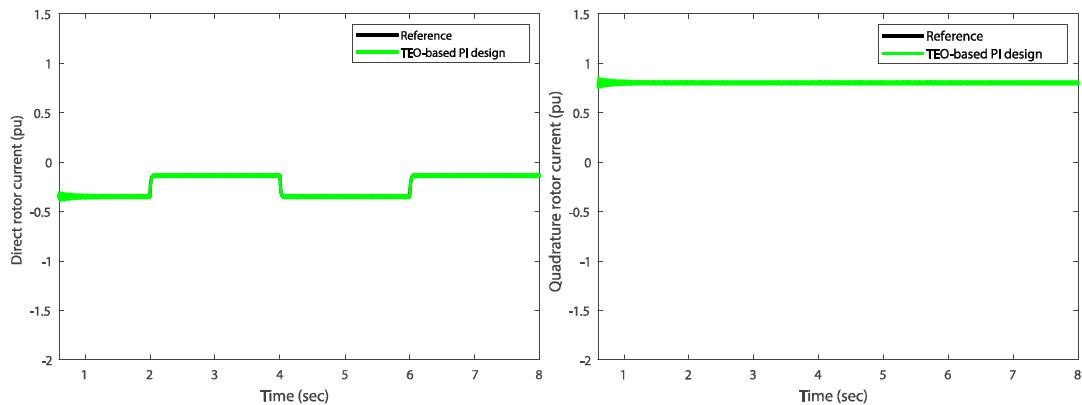
Figure 14. Performance comparison of the controlled reactive power under different PI controllers’ tuning methods.